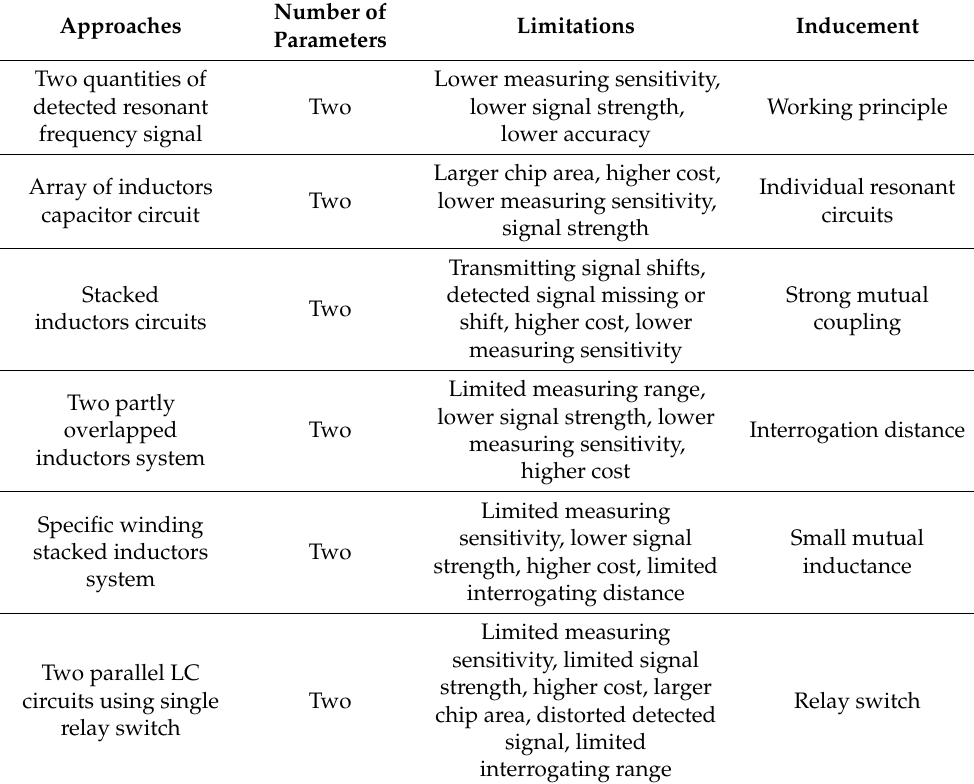
Table 1. Comparison of different multi-parameter approaches’ limitations and